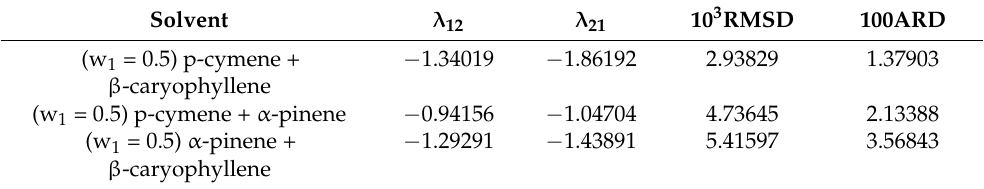
Table 8. Regression results and model parameters of the modified Wilson model of dehydroabietic acid in solvents.